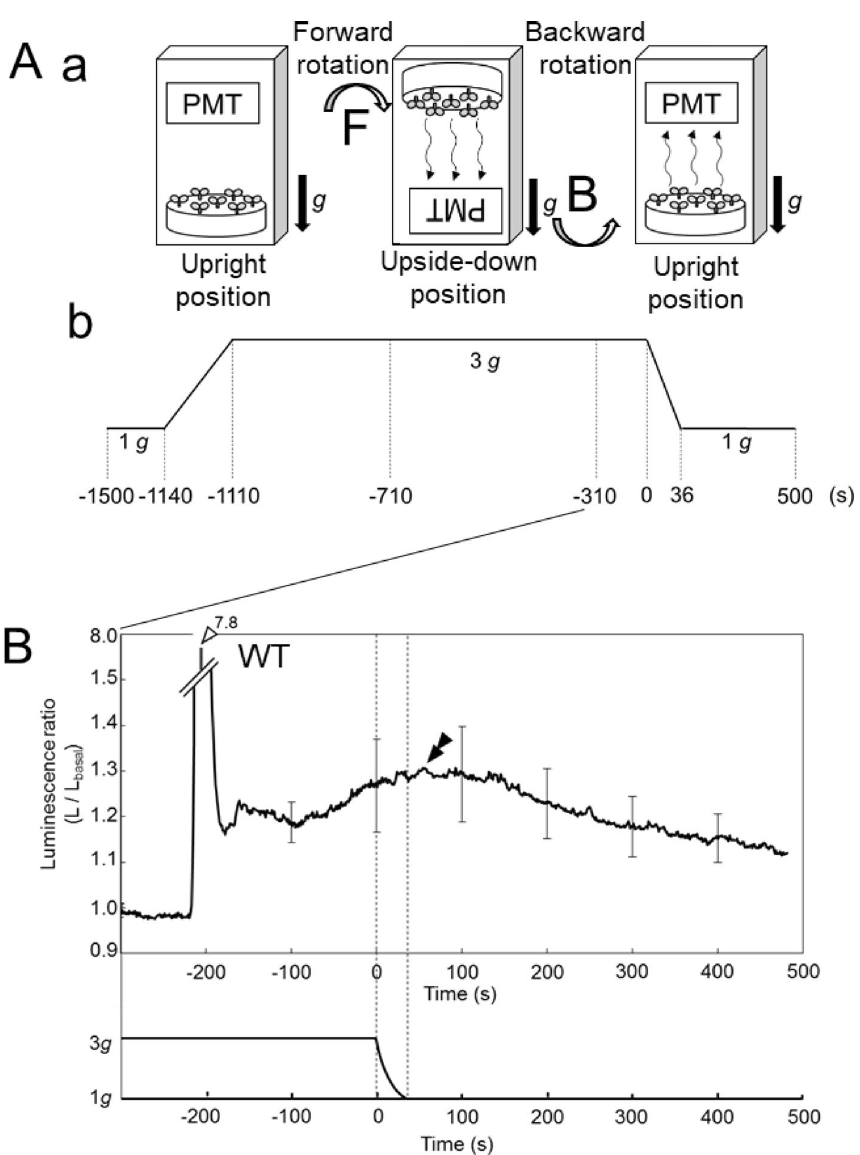
gravitational acceleration from 3 to 1 g. ( A ) diagram of the experimental protocol. ( B ) The averaged trace of changes in the luminescence ratio in response to gravistimulation. Gravitational acceleration decreased from 3 to 1 g in 36 s. Data represent means ± SD. n =